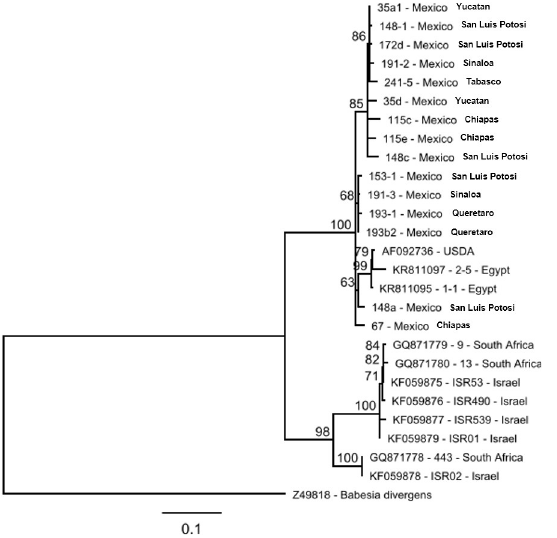
Fig 8. Phylogenetic tree constructed using RAP1 amino acid sequences generated in this study and similar sequences deposited in GenBank (sequence names start with an accession number). Translated Z49818 sequence of the B . divergens rap1 gene served as an outgroup. Bootstrap support values over 50 are shown on the nodes.